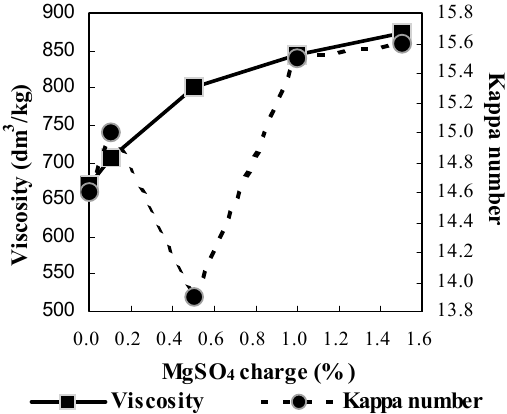
Figure 3. Influence of MgSO 4 charge on screened yield and brightness (active alkali charge 23%, time to maximum temperature 55–65 min, time at maximum temperature 180 min, initial pressure of oxygen 0.6 MPa, and de-pithed bagasse consistency 12%). Molecules 2016 , 21 , 85 8 of 11